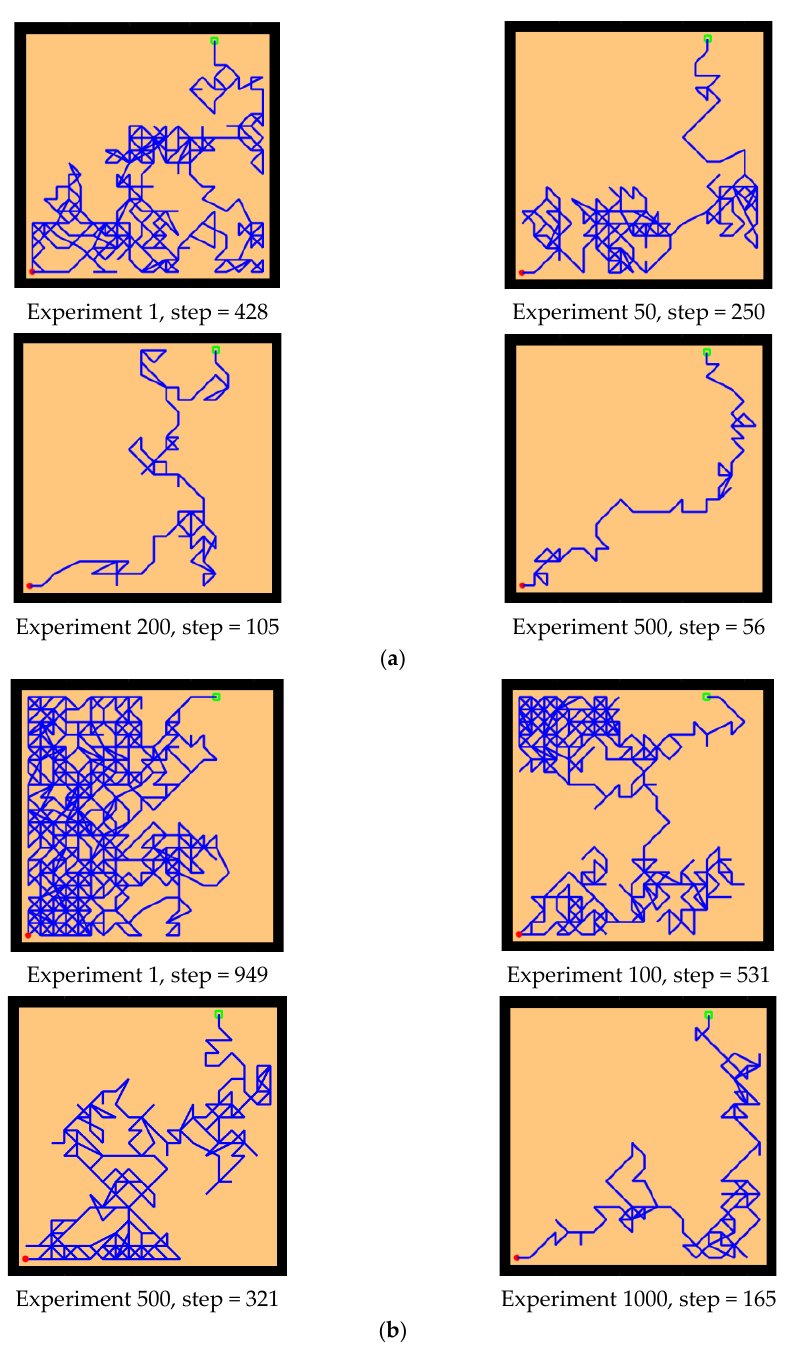
Figure 15. Further comparative experiment with the Q-learning model and our model in the water maze. ( a ) Our model. ( b ) Q-learning model.